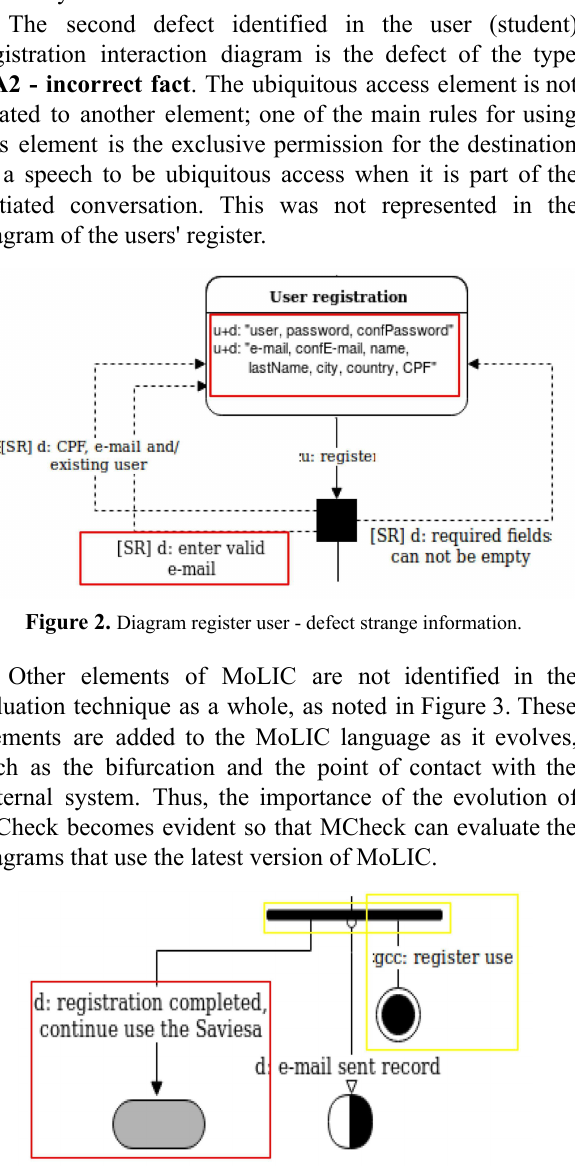
Figure 3. Diagram register user - defect factor